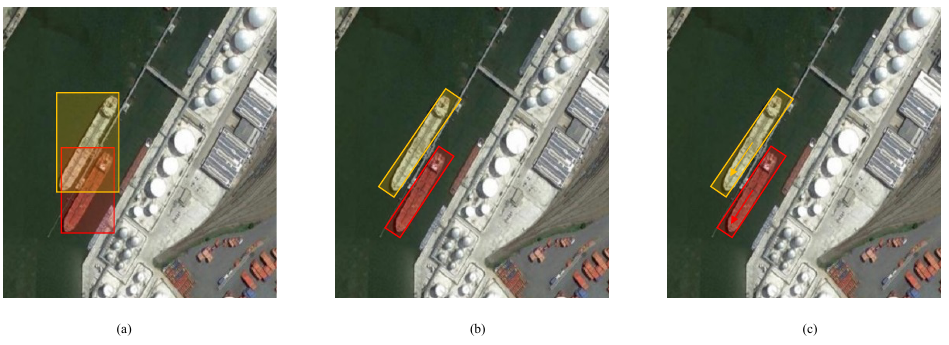
Figure 1. Three types of representation for object-detection results. ( a ) Horizontal boxes. ( b ) Tilted boxes without direction. ( c ) Tilted boxes with